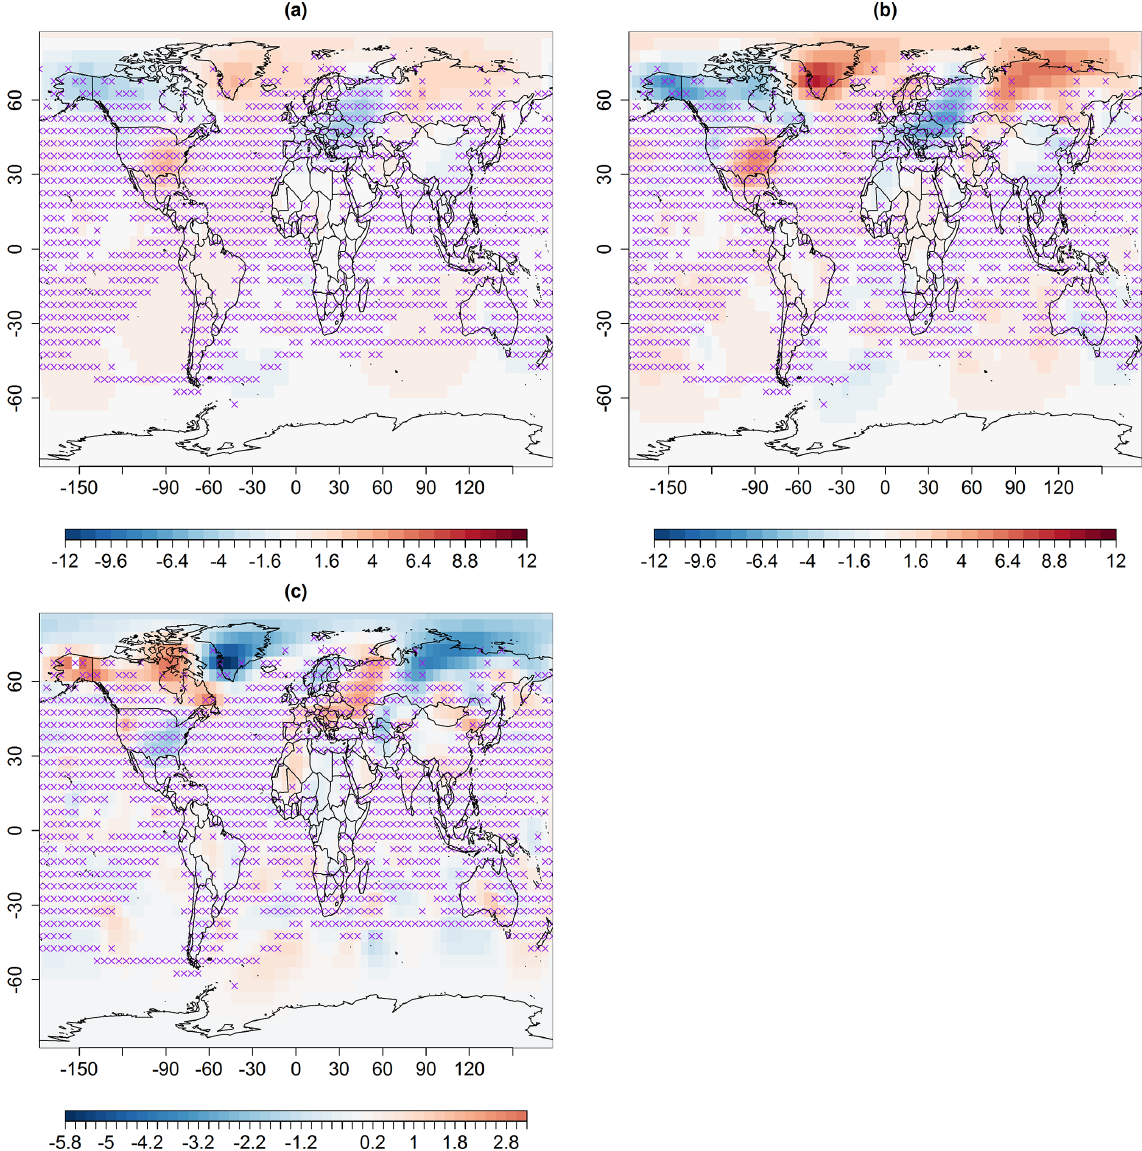
Figure B1. Spatial predictions (in degrees Celsius) for February 1932, using multi-resolution lattice kriging based on (a) ABC, using a variogram (Sect. 2.1), and (b) the profile maximum likelihood approach (Nychka et al., 2015) used to create data in Ilyas et al. (2017). (c) The difference in panels (a) and (b) , i.e., (a) – (b) . The × signs show observed spatial sites (purple).